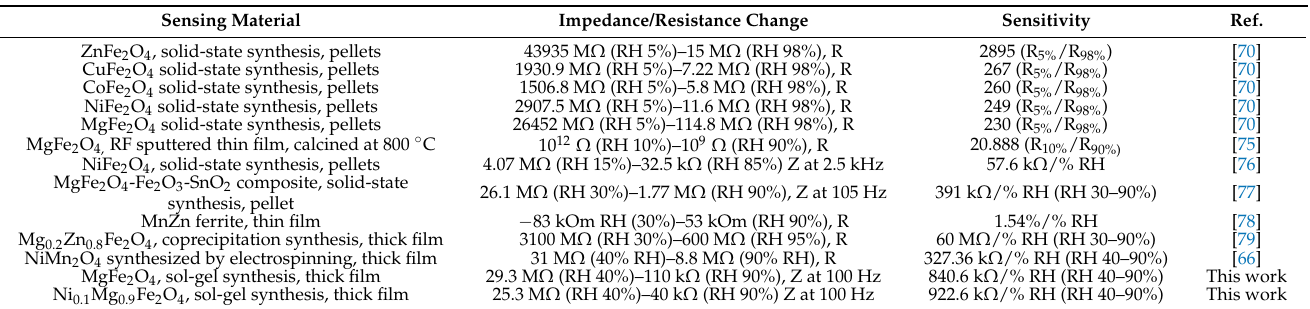
Table 5. Literature comparison of humidity sensing metal oxides.